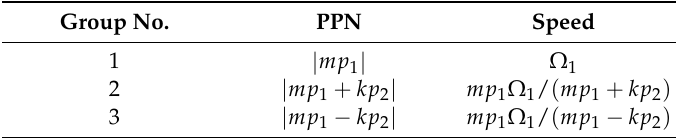
Table 1. Field harmonics excited by the rotor permanent magnets (PMs). Group No.